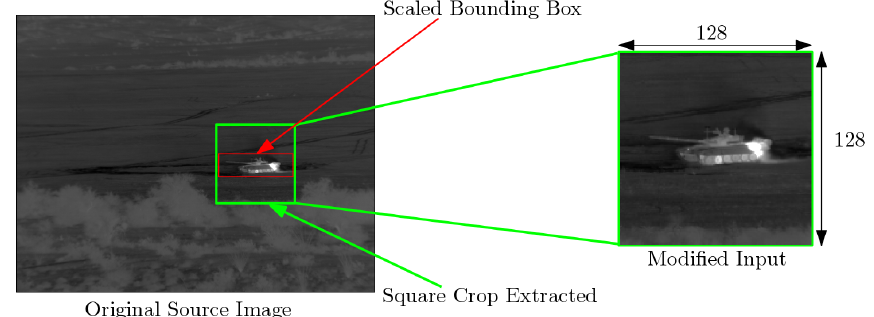
Figure 5. An extraction of target exemplars accounting for scaling errors: The original bounding box is shown in red, and the scaled one is in